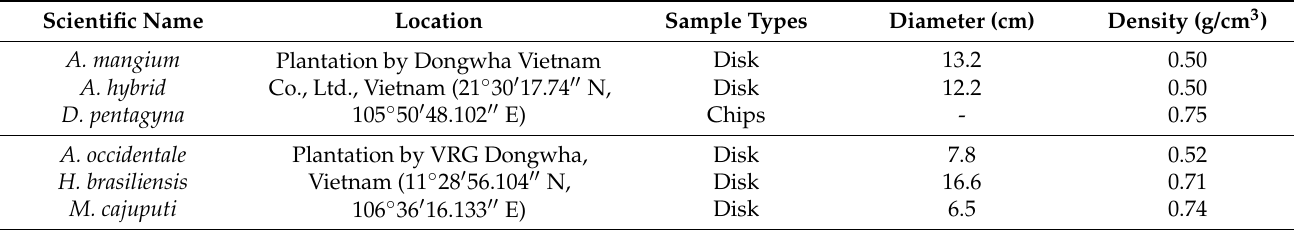
Table 1. Fundamental information of six wood species